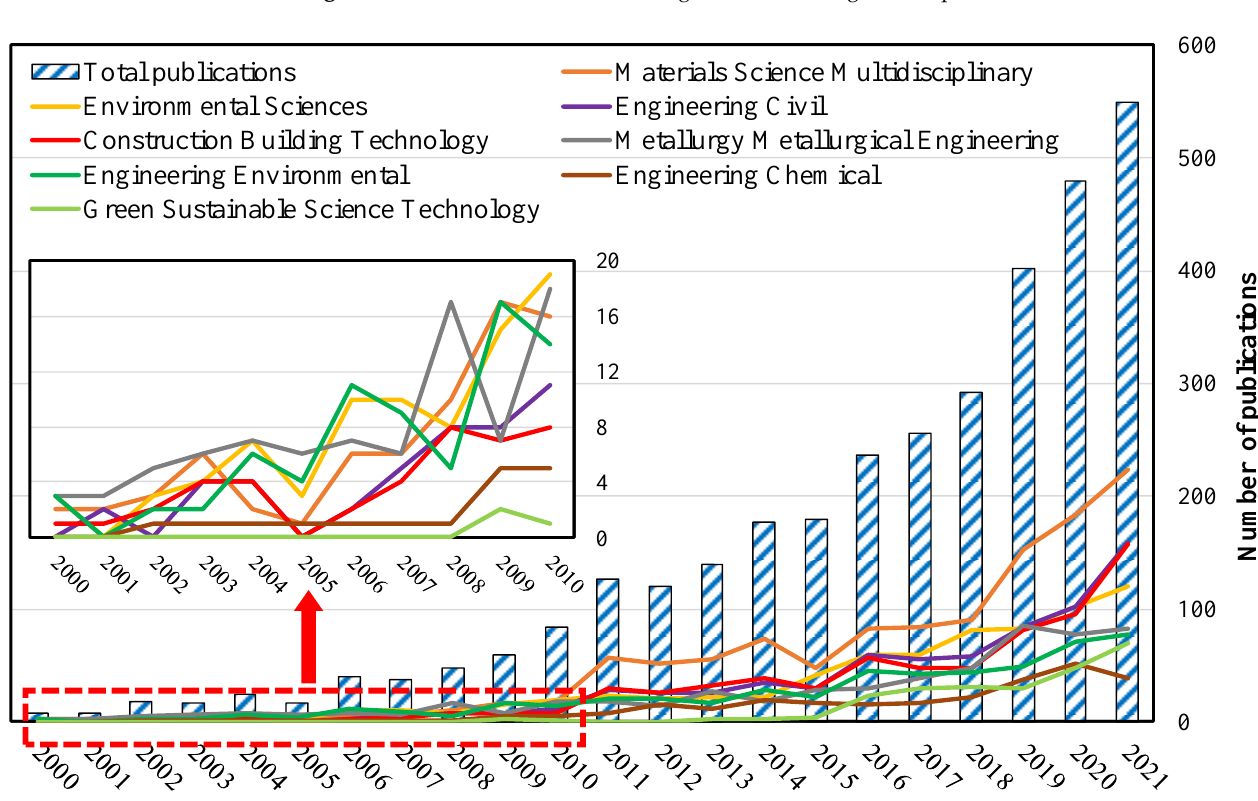
Figure 1. Distribution of research categories of steel slag-related publications.